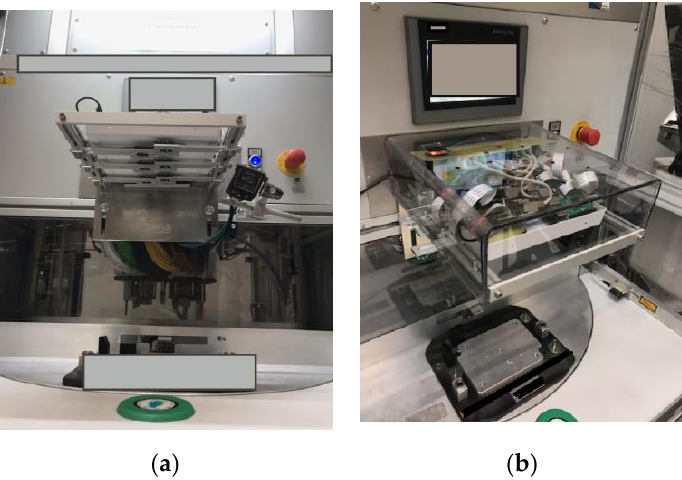
Figure 18. First phase of the IP-LC-FD prototype ( a ) upper side view over the installed Raspberry Pis , ( b ) lower side view over the cameras that are magnetically attached to the illuminating surface, ( c ) the prototype installed on the operational machine.